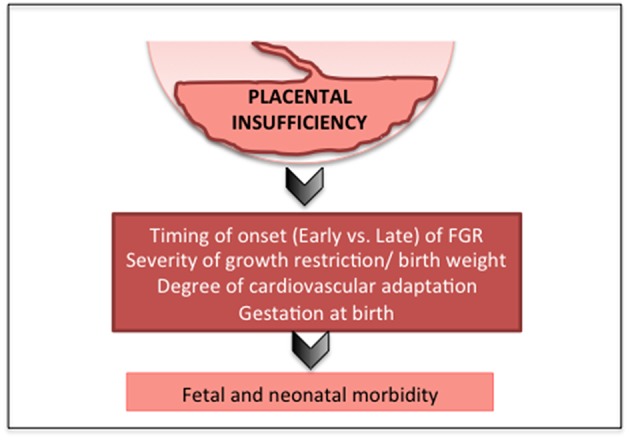
Factors that affect outcomes in FGR.